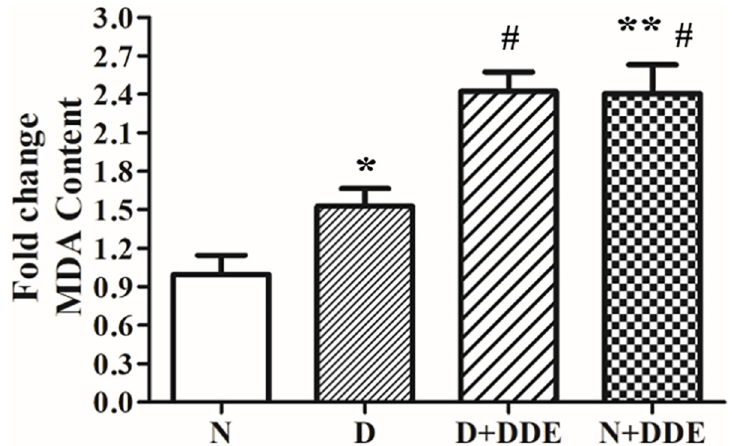
Fig 4. Hepatic lipid peroxidation. Analysis of the hepatic lipid peroxidation measured as MDA content in rat liver homogenate. Significance of differences is shown: � p < 0 . 05 vs. N; �� p < 0 . 01 vs. N; # p < 0 . 05 vs. D.